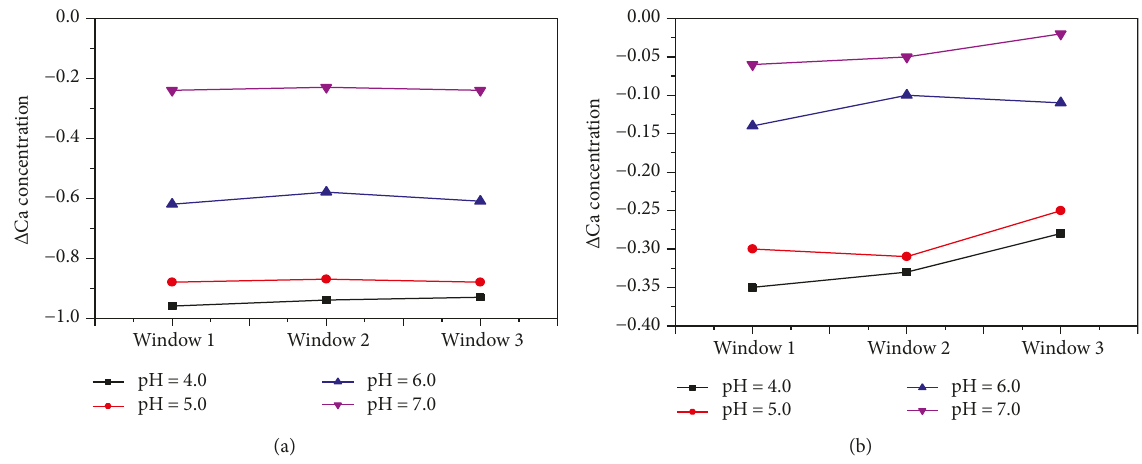
Figure 11: Ca concentration change after the core fl ooding experiment. (a) Longmaxi shale and (b) Green River shale.